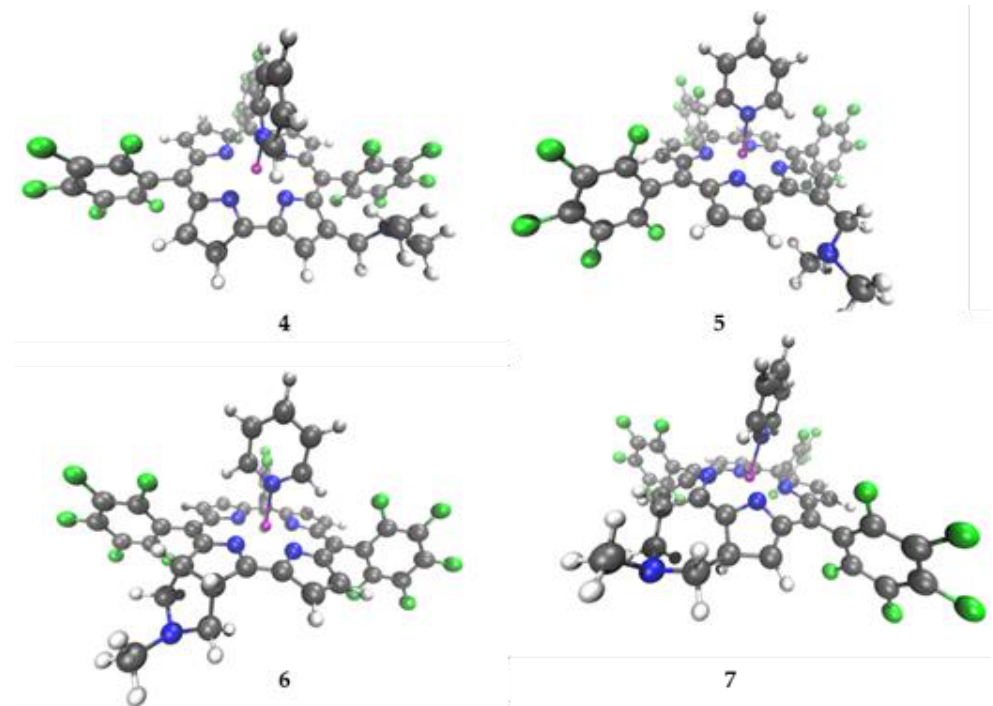
Figure 2. Structures for compounds 4 , 5 , 6 , and 7 optimized with MOPAC2016 [59] (in all images, atom colors are: hydrogen (white), carbon (gray), nitrogen (blue), fluorine (green), and gallium (magenta)).